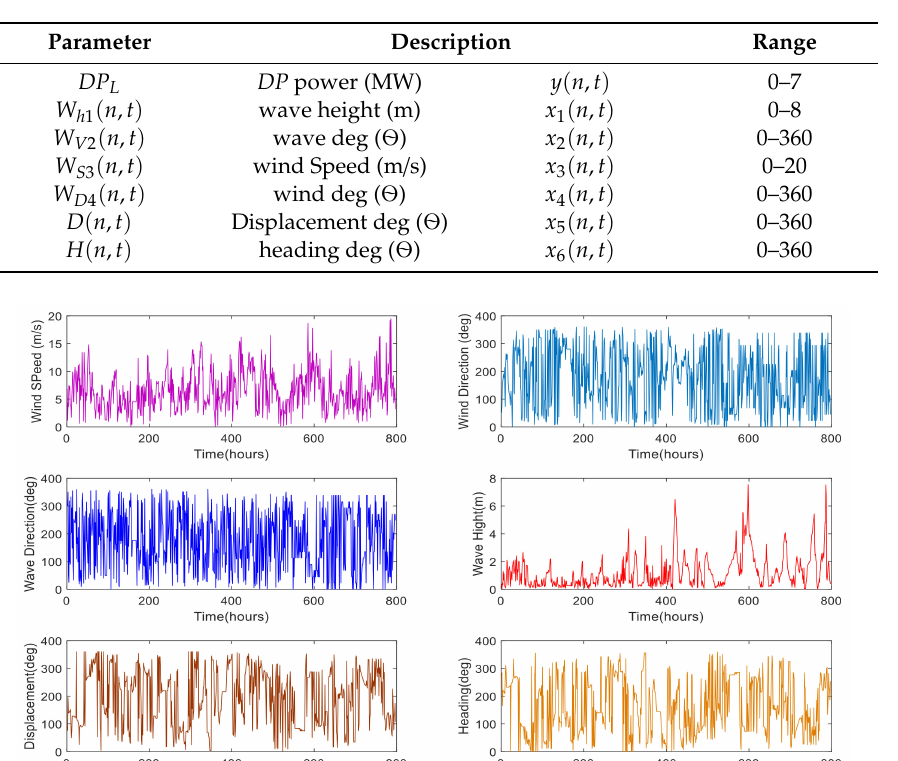
Table 1. Parameters used in NARX-NN.